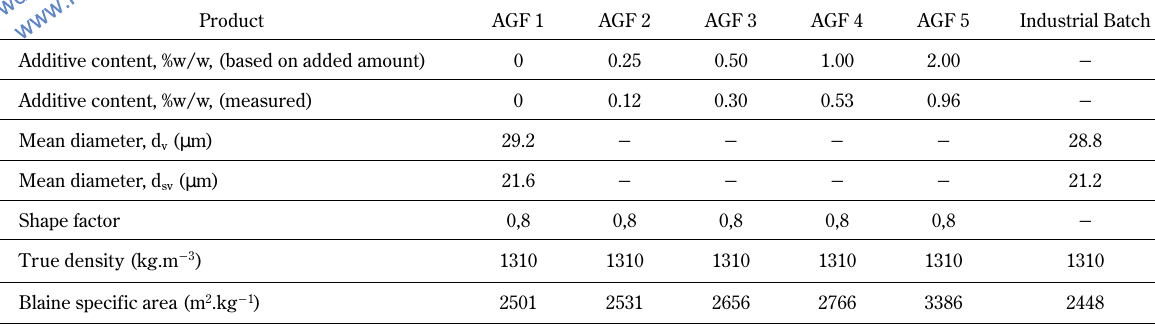
Table 1 Characteristics of powder